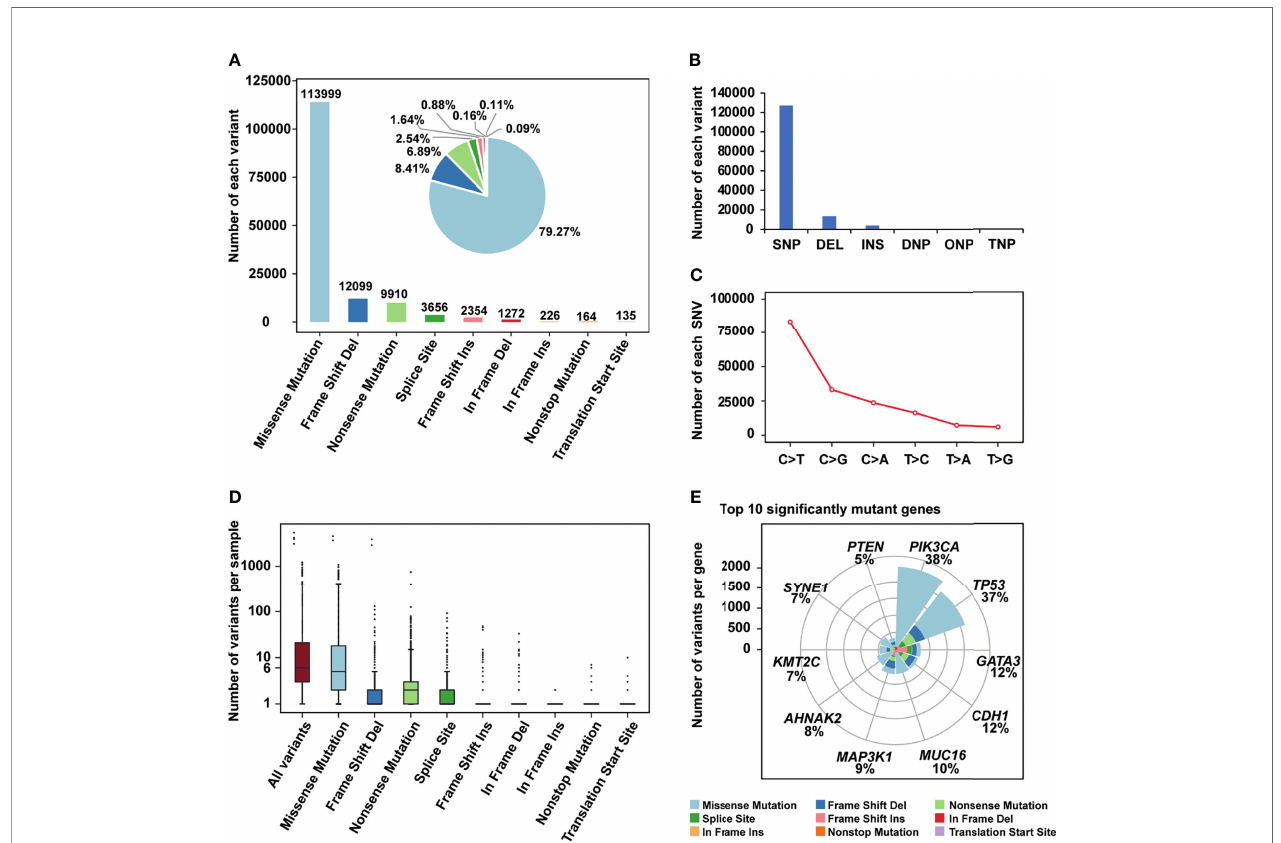
FIGURE 1 | The mutation landscape of breast cancer cohort. (A) Bar plot and pie plot showing the number of each variant; (B) Bar plot and pie plot showing the number of each variant type; (C) Line graph showing the number of each SNV class; (D) Boxplot showing the number of variants per sample, the median of mutations per patient is 6; (E) Top 10 signi fi cantly mutant genes and the composition of